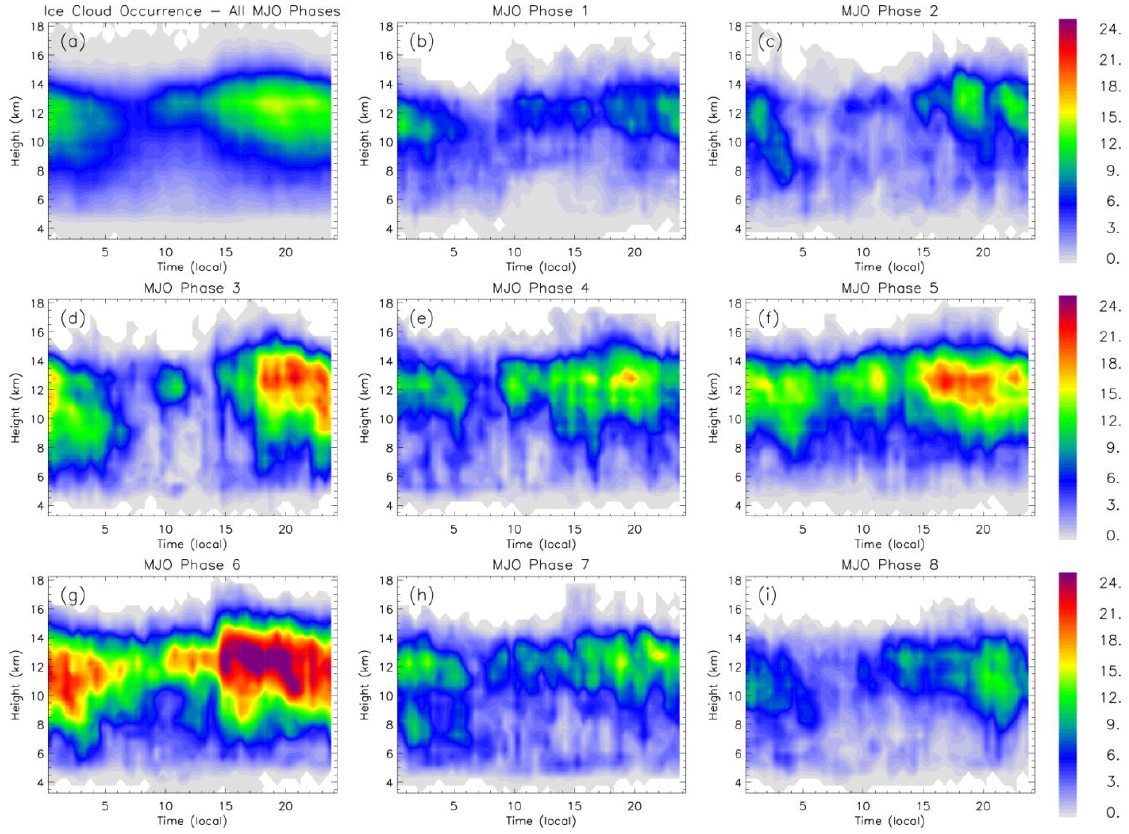
Fig. 17. Time-height cross-section of the frequency of ice cloud occurrence (in %) over Darwin with all regimes included (a) , and for the following MJO phases: 1 (b) , 2 (c) , 3 (d) , 4 (e) , 5 (f) , 6 (g) , 7 (h) , 8 (i).